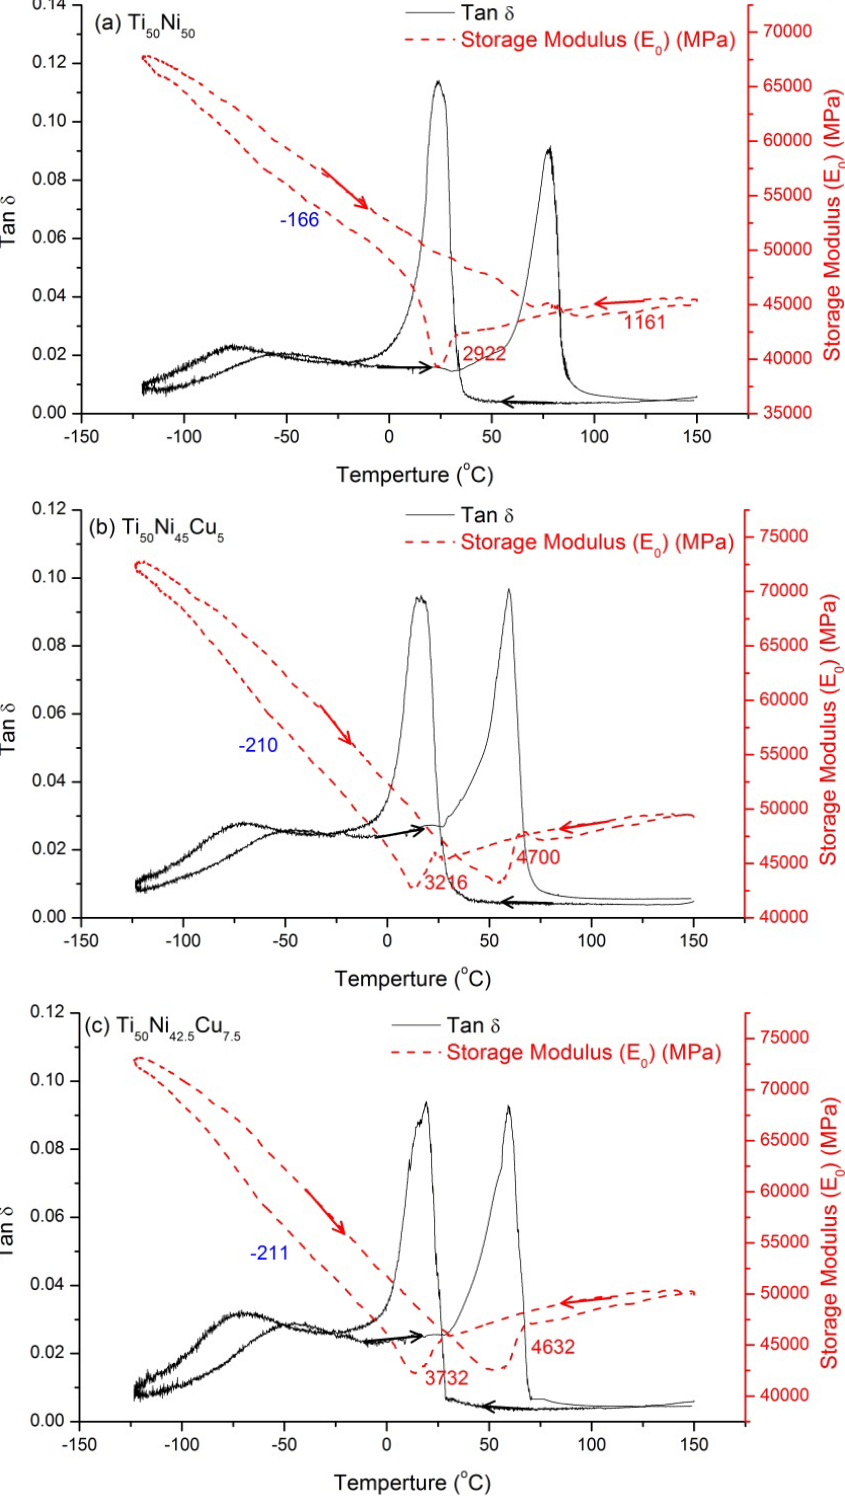
) curves for Ti Ni Cu SMAs. 0 50 50 − x x slope in B19’ martensite, and 0 softening and 0